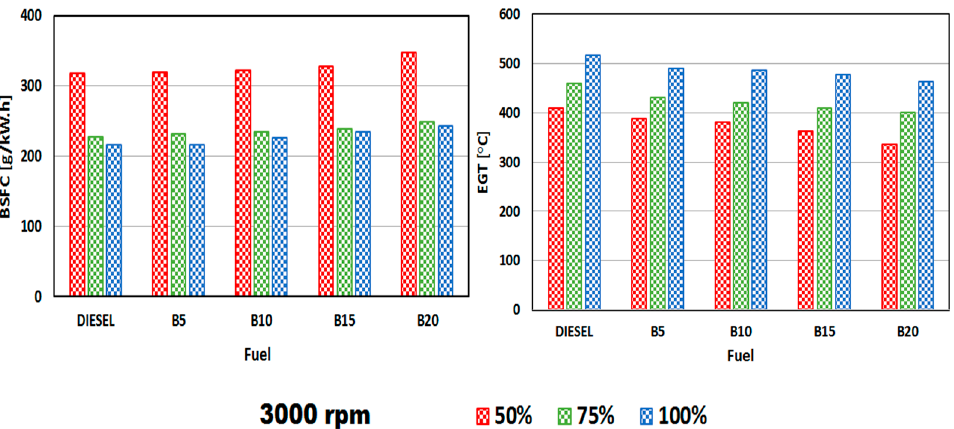
Figure 7. DSO biodiesel engine performance metrics under three loads and 3000 rpm.